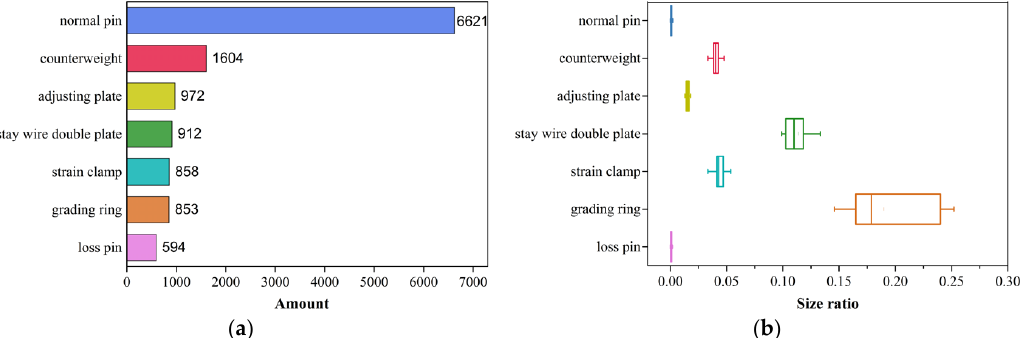
Figure 3. The statistics of the detected objects. ( a ) The amount of the detected objects, ( b ) the size ratio of the detected objects.